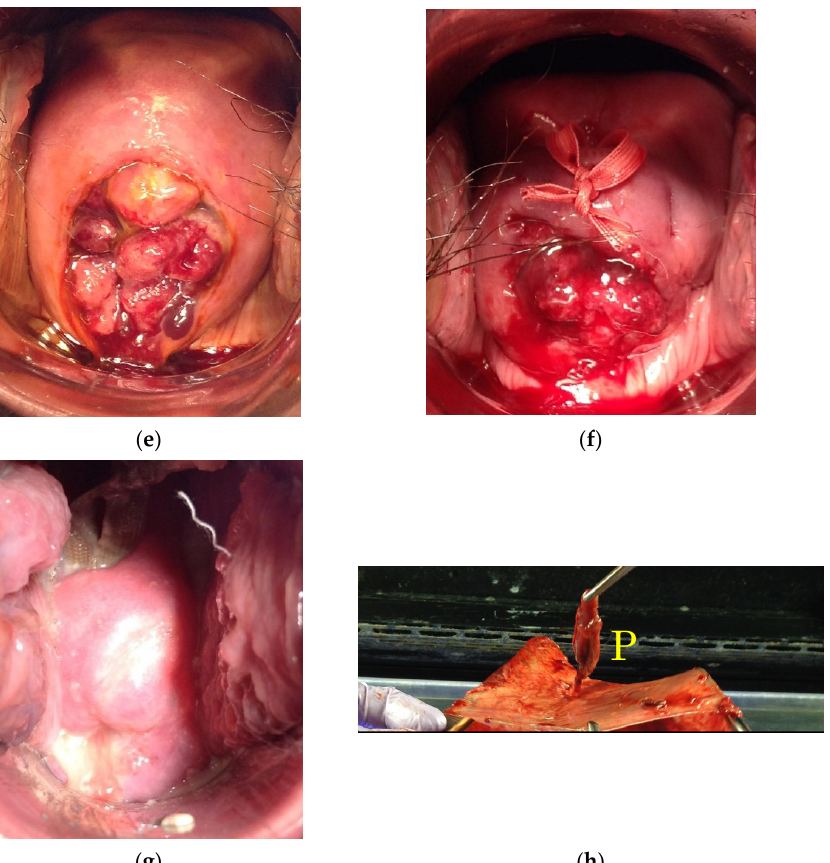
Figure 3. Trans-vaginal ultrasound images show decidual polyps protruding from the intra-uterine cavity and a shortened cervix, which necessitated a cervical cerclage, observed at 17 weeks of gestation. ( a ), the polyps migrated inside the area of the cervical canal at 22 weeks of gestation; ( b ), and further migrated upward at 26 weeks of gestation ( c ). They could not be recognized anymore by a trans-vaginal ultrasound at 29 weeks of gestation ( d ). Speculum examination during the operation showed multiple polyps ( e ) and their protrusion even after the cerclage procedure at 17 weeks of gestation ( f ); however, polyps were not visible at 22 weeks of gestation ( g ). A decidual polyp was